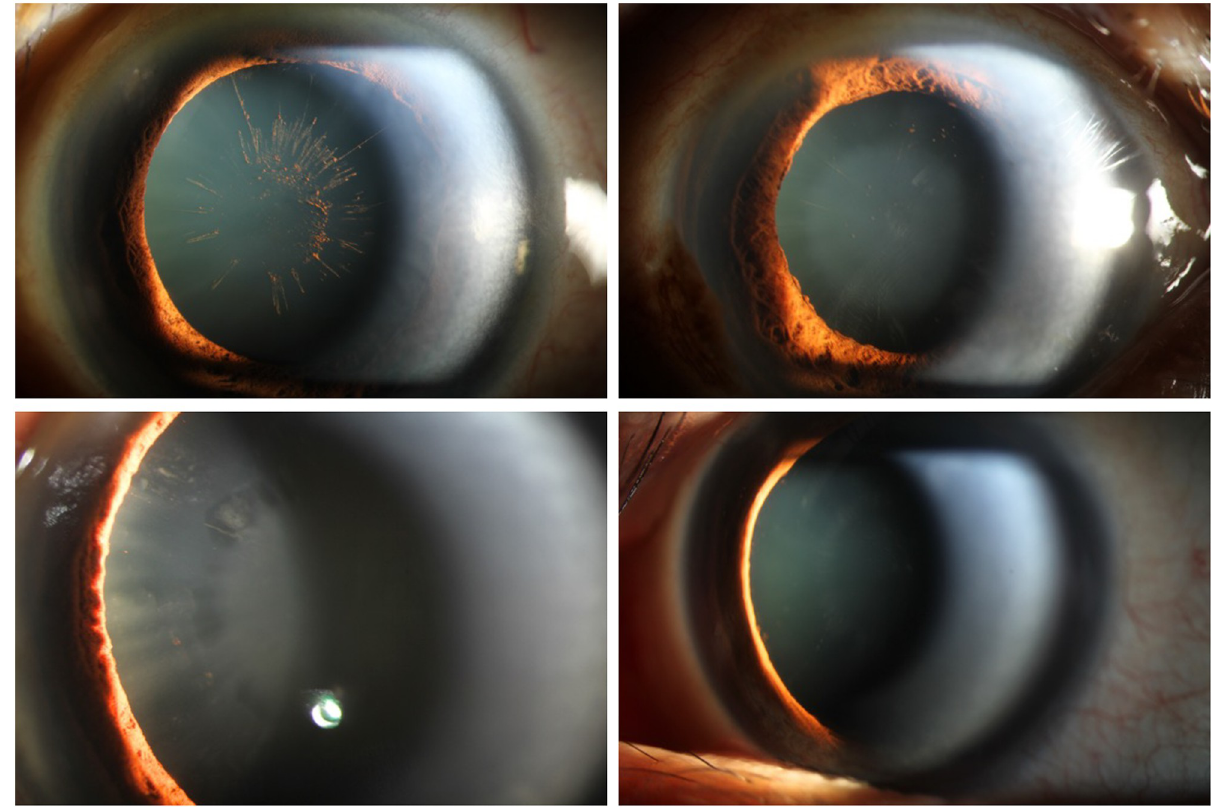
Fig 1. Anterior segment photographs of preclinical pseudoexfoliation syndrome. (A) Pigmented spoke wheel deposition on anterior lens capsule (B) Faint central disc within photopic pupil (C) Midperiphery cleft/lacunae (D) White-spoke pattern at midperiphery.